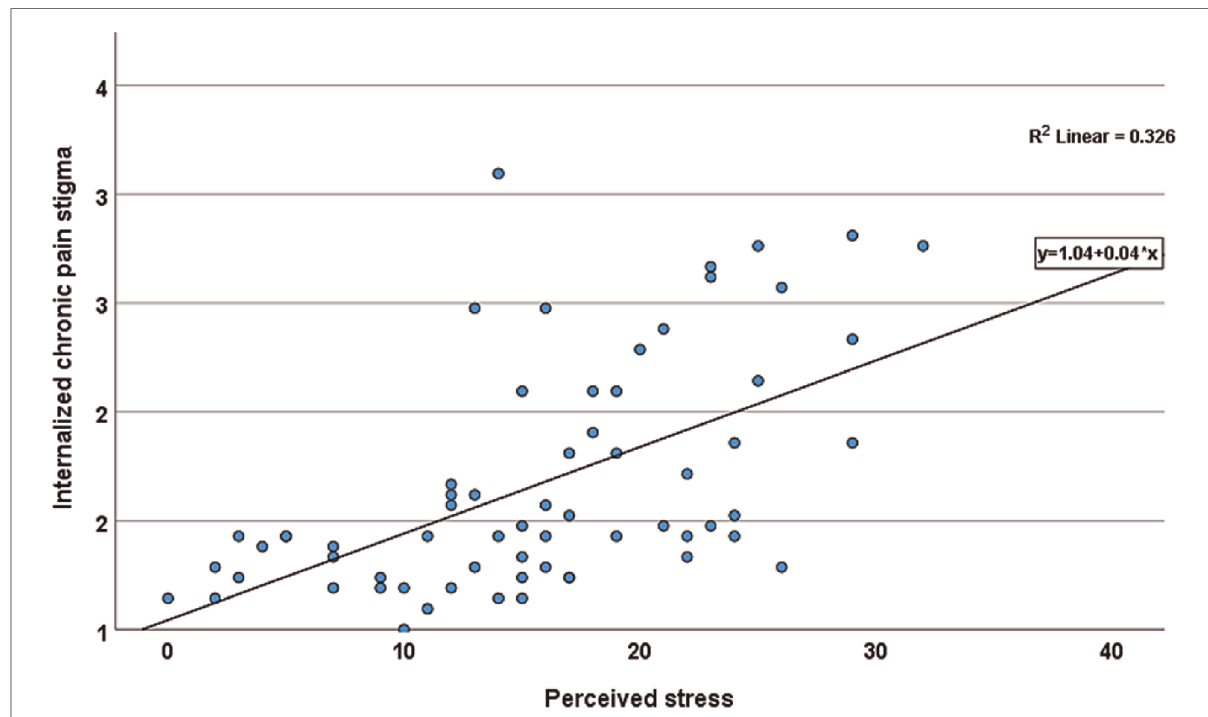
FIGURE 1 Scatter plot of the relationship between internalized chronic pain stigma and perceived stress among adults with non-speci fi c cLBP. Line shows the linear relationship between internalized chronic pain stigma and perceived